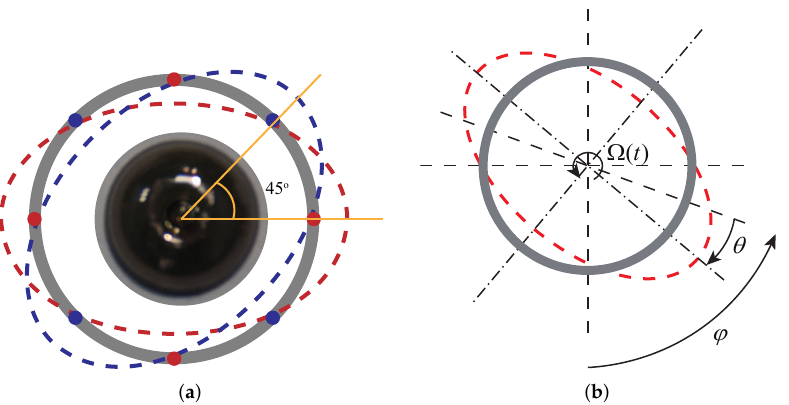
Figure 5. The modes and precession principle of the microhemispherical shell resonator ( n = 2). ( a ) The n = 2 modes of the microhemispherical shell resonator. ( b ) The precession principle of hemispherical resonant